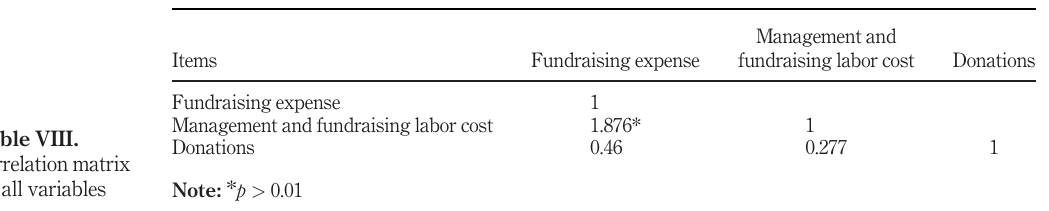
Table IX. Taking the program ef fi ciency analysis results together, only four DMUs (DMU 2, 4, 6 and 13) were identi fi ed as being ef fi cient in both program ef fi ciency and fundraising ef fi ciency. Studying the characteristics of these four DMUs reveals that three of them were ranked top ten organizations in the donation amount given by individuals and international organizations. They have 38 years of operation on average, and their parent body organizations are international humanitarian assistance organizations. The DMU 13 which is 1 out of 4 DMUs scoring 100 per cent ef fi ciency in both program and fundraising has a relatively short history of 18 years in operation and a small number of employees of 35.